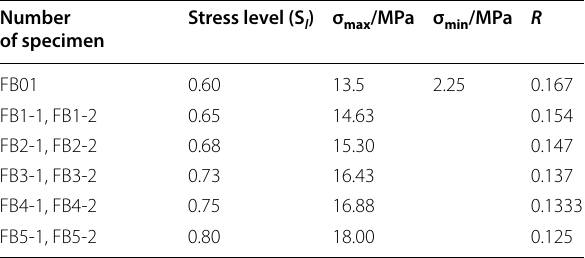
Table 3 Loading scheme of specimen under cyclic